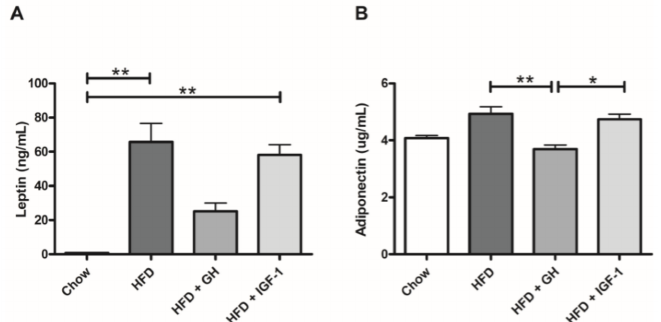
Figure 4. Serum adipokines levels: ( A ) Leptin and ( B ) adiponectin. Growth hormone supplementation attenuated high fat diet (HFD) associated increase of leptin serum levels, and reduced serum adiponectin levels compared to HFD and HFD + IGF-1. * p < 0.05; ** p <